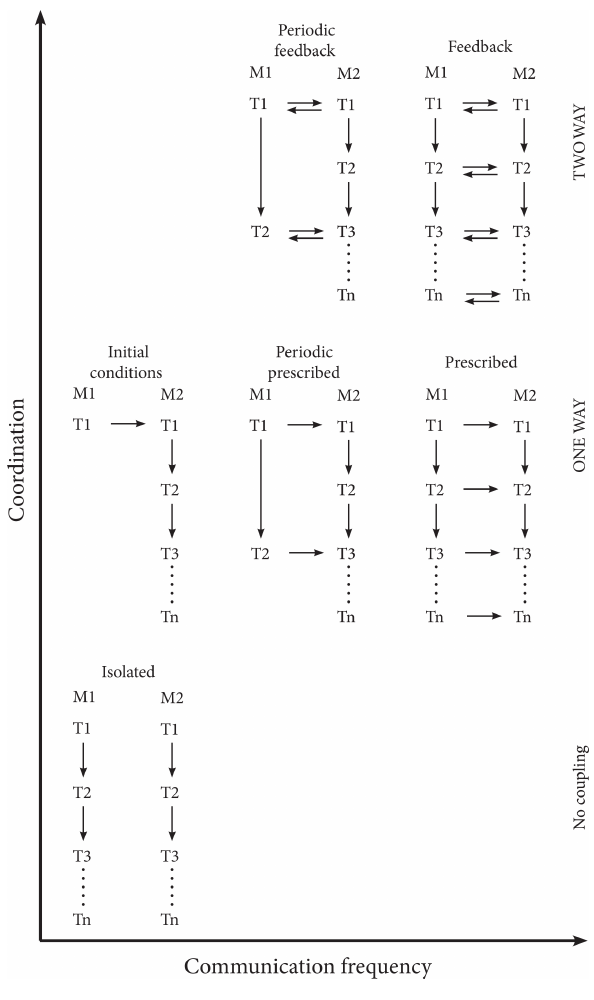
Figure 2. Conceptual outline of the frequency of model commu- nication and coordination of interaction between models from no coupling to one-way and two-way feedback. Examples are not ex- haustive but illustrate common approaches used. M1: model 1; M2: model 2; T1: time step 1; Tn: time step n . Initial conditions, where one model is merely used to set the initial conditions of another; pe- riodic perturbations, whereby one model updates data or variables used by another periodically and unilaterally; prescription, which is common to climate models that use a prescribed trajectory of land-cover data that do not endogenously change; periodic two-way feedback, whereby two different modelled processes may act at dif- ferent temporal resolutions and feedbacks occur upon alignment; and two-way feedback where the modelled processes are dependent on the results and behaviour of each